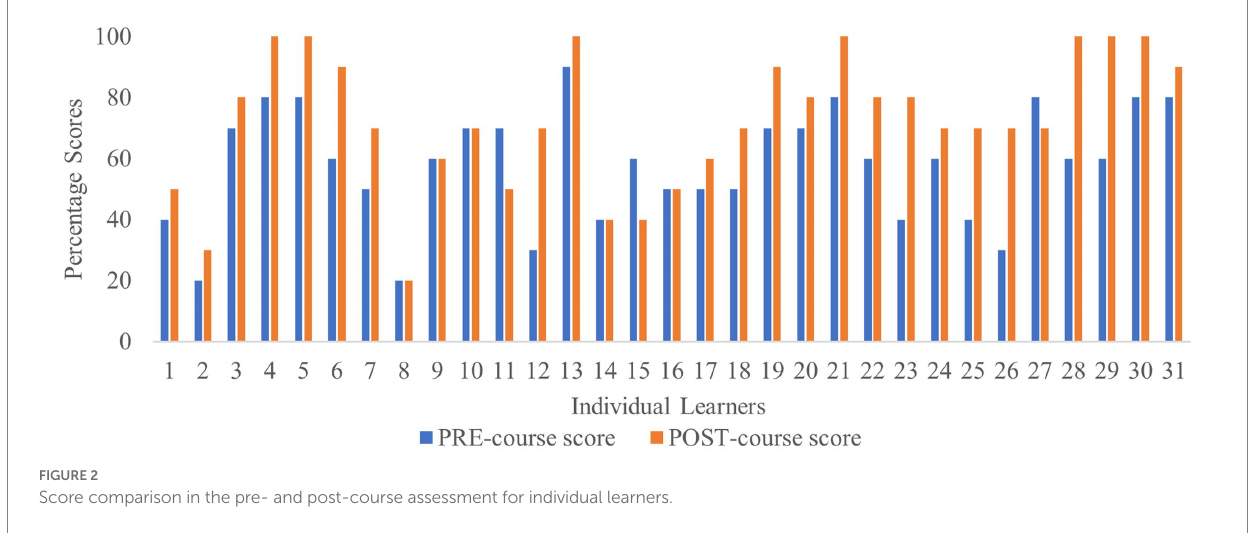
FIGURE 2 Score comparison in the pre- and post-course assessment for individual learners.